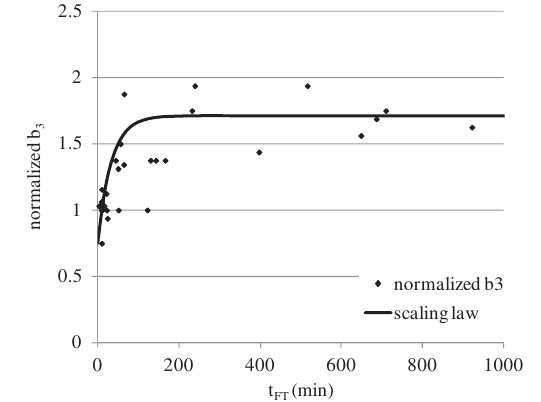
FIG. 10. Normalized b 3 decay amplitude and the scaling law against the flattop